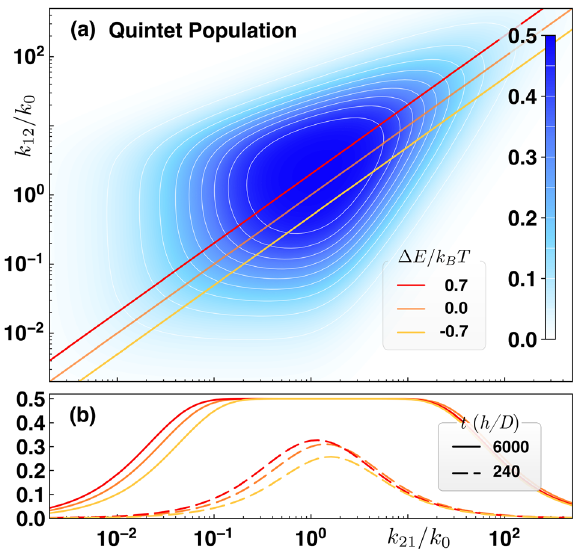
Fig. 2 Quintet formation driven by stochastic conformational switching at zero- fi eld. a Blue shading indicates quintet population p 5 ( t ) for t = 1200 periods (one period is h / D , Planck ’ s constant divided by the ZFS constant D ) or ≈ 1.05 μ s, as a function of the switching rates k 12 , k 21 in units of k 0 = 3( J 1 + J 2 )/2 h . This is in accordance with the μ s rise time of quintets measured by Tayebjee et al. 21 . Quintet formation proceeds ef fi ciently when the stochastic resonance condition of Eq. (5) is respected. Warm-coloured lines indicate regions of constant k 21 / k 12 = Δ E / k B T where Δ E is the energy difference between the two conformations, k B is Boltzmann ’ s constant, and T is the temperature. b Slices of p 5 ( t ) at different k 21 / k 12 values for two different times. The stochastic resonance condition for rates is not generally symmetric in k ij . Stochastic resonance drives quintet formation by switching between two non-commuting spin Hamiltonians. At the individual trajectory level, 1 (TT) and 5 (TT) can undergo complete population inversion. However, the ensemble average of p 5 ( t ) never exceeds 1/2. This is because, for suf fi ciently long times, each individual spin trajectory ergodically explores the space of accessible states, driving the ensemble towards the state of maximal entropy. See Supplementary Note 1 for parameters of the spin